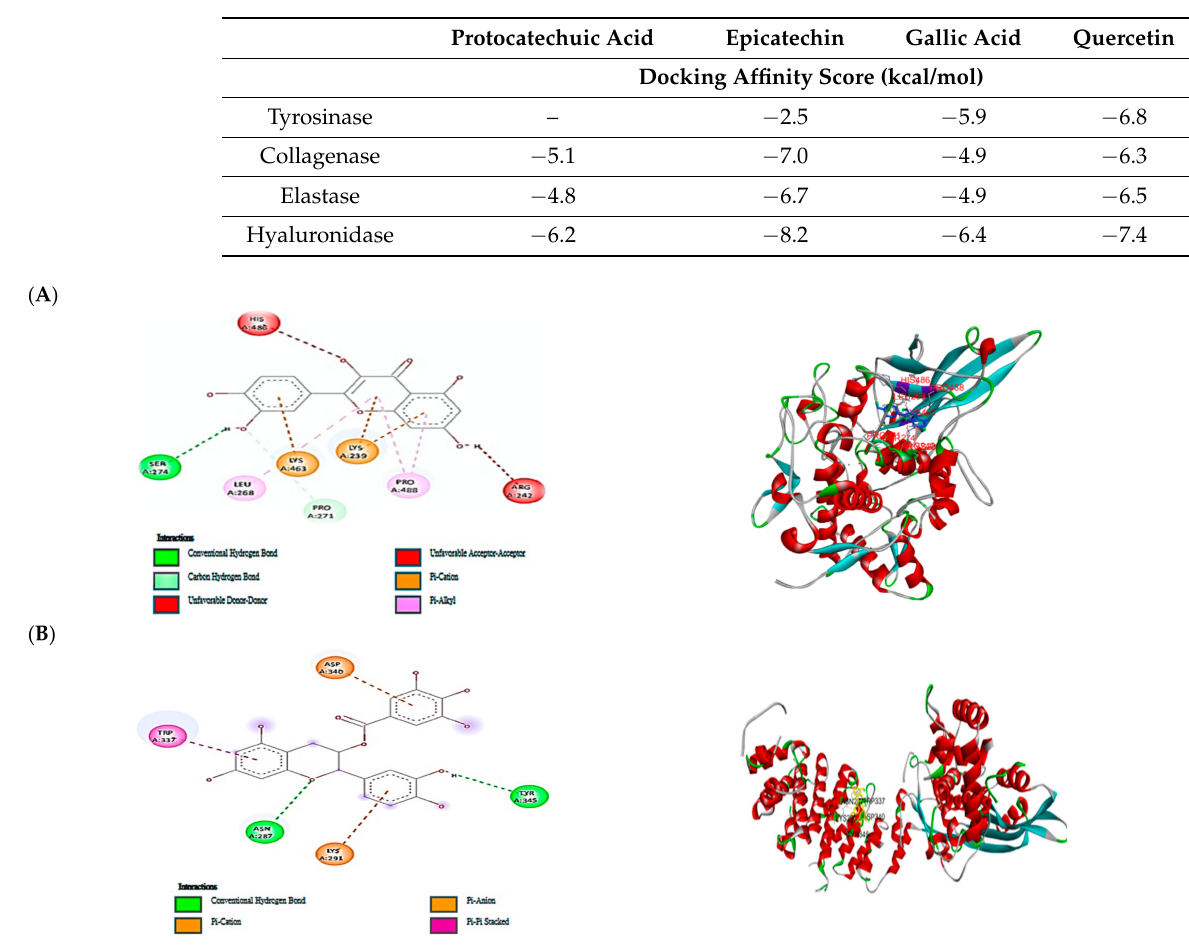
Table 3. Results of the molecular docking analysis of protocatechuic acid, epicatechin, gallic acid, and quercetin.